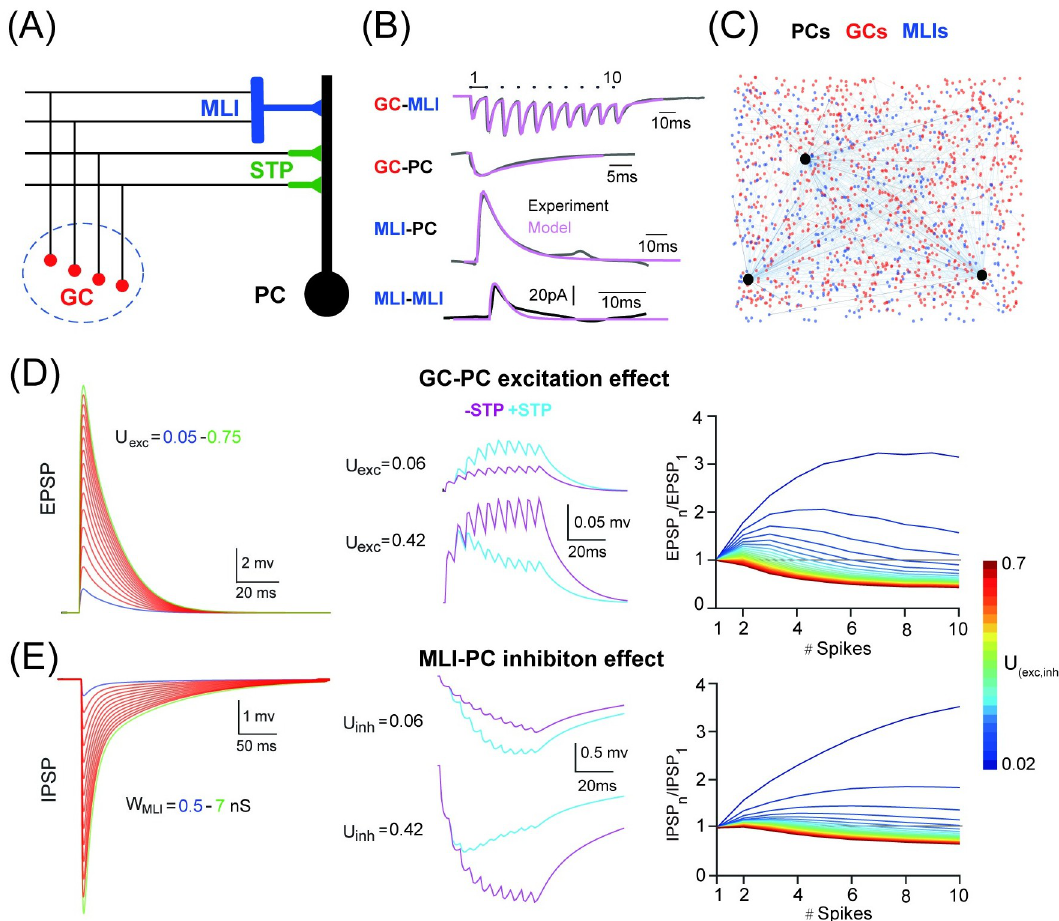
Fig 1. PC dynamics controlled by excitation and inhibition. (A) Schematic illustration of feedforward excitatory GC-PC short-term plasticity (STP) pathway and inhibitory GC-MLI-PC pathway on a PC. Granular cells (GCs, red), molecular intermediate neurons (MLIs, blue) and Purkinje cells (PCs, black). (B) Postsynaptic currents of four types of synapses from experimental data fitted by models. (C) The PC network with 50 PCs (black), 1000 GCs (red), and 500 MLIs (blue). For illustration, only 3 PCs are shown. (D) PC in response to the GC-PC input. (Left) EPSPs triggered by a single GC spike by varying GC-PC synaptic STP amplitudes U exc (0.05– 0.75 with a 0.05 increment). (Middle) EPSPs triggered by a train of 10 spikes at 200 Hz at two different values of U: U exc = 0.06 for facilitation and U exc = 0.42 for depression, with (light blue) and without (purple) STP switched on. (Right) STP described by the ratio EPSP n /EPSP 1 showing facilitation or depression in a train of a varying number of burst spikes under different U (0.02-0.7, fixed burst frequency at 200 Hz). (E) Similar to D but for IPSPs triggered by the MLI-PC input. Single IPSPs induced by different strengths W MLI (0.5–7 with a 0.5